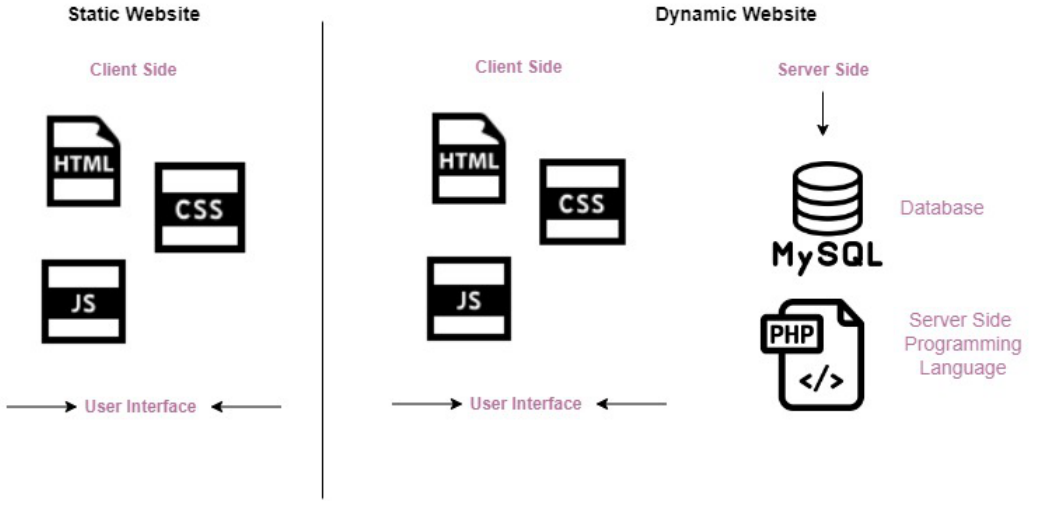
Figure 3. Static and Dynamic